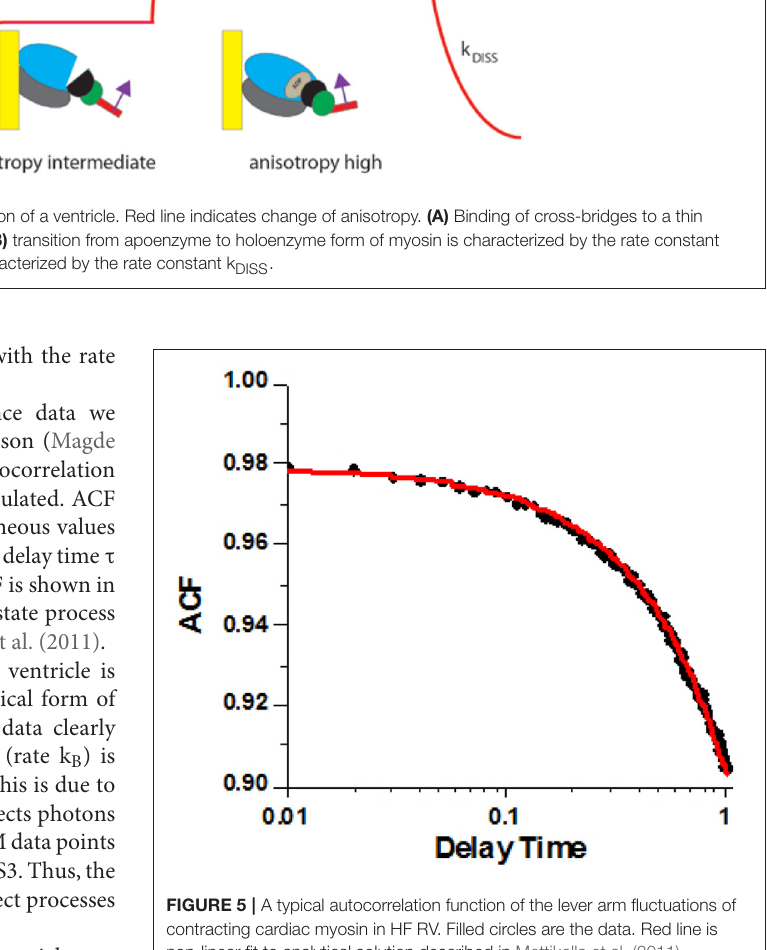
FIGURE 5 | A typical autocorrelation function of the lever arm fluctuations of contracting cardiac myosin in HF RV. Filled circles are the data. Red line is non-linear fit to analytical solution described in Mettikolla et al. (2011).